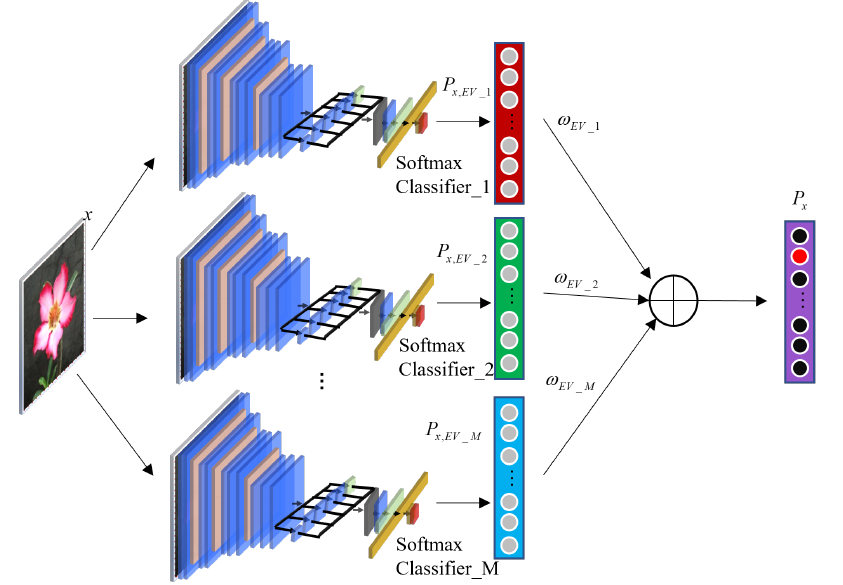
Figure 5. A diagram of decision